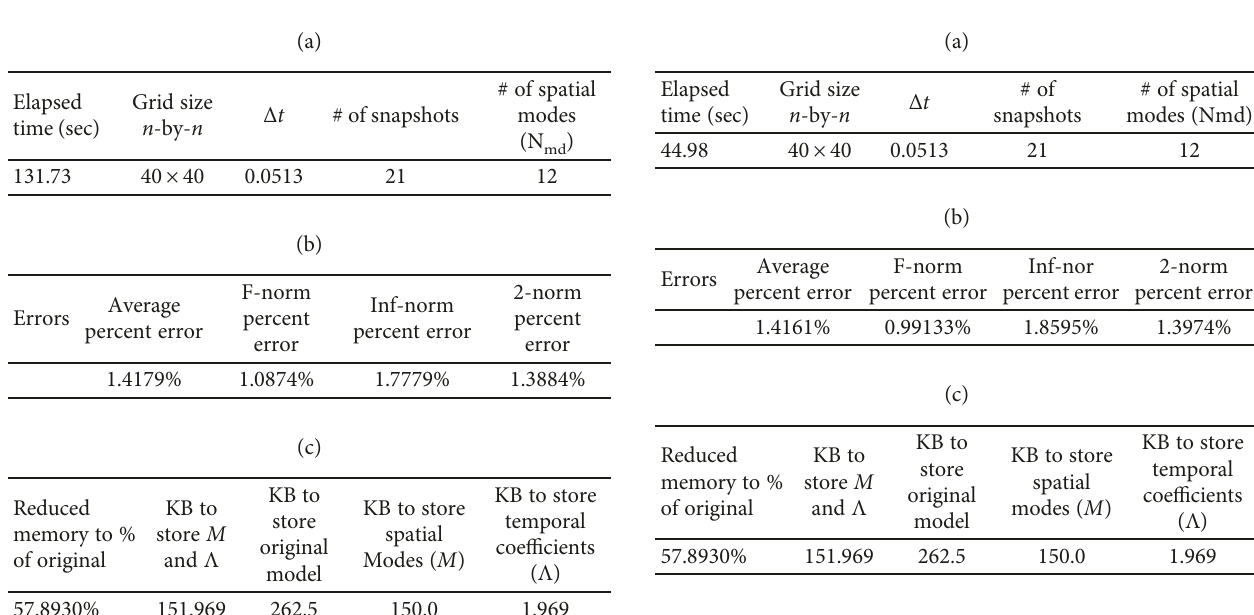
Table 1: Algorithm 1 results (40 × 40 grid, N = 21 , N